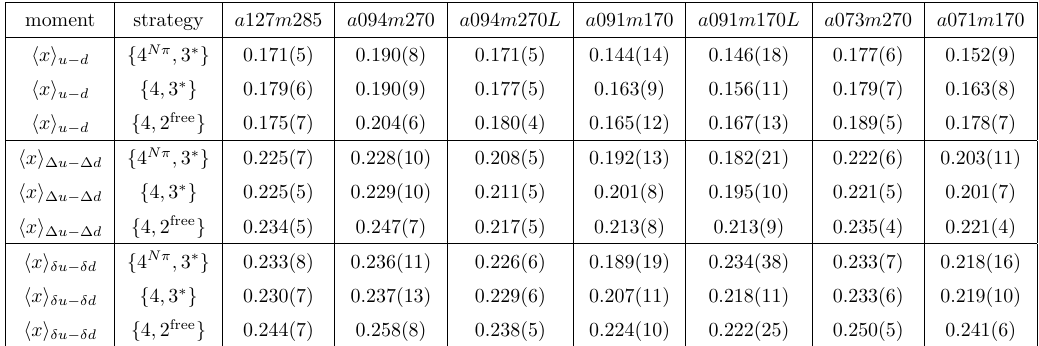
Renormalized moments for all three fit-strategies with Z factors obtained using Method B defined in this appendix